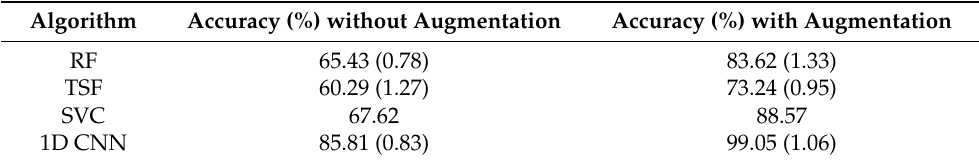
Table 4. Comparative results of data augmentation experiments.